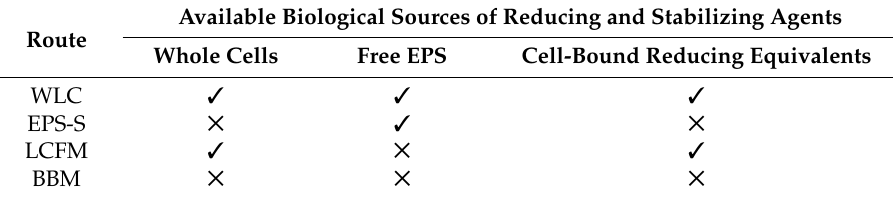
Figure 3. Evolution of AgNP SPR intensity at 425 nm vs. time for WLC, EPS-S and LCFM at AgNO 3 concentrations of: ( a ) 1.250 mM; ( b ) 0.625 mM; and ( c ) 0.125 mM.